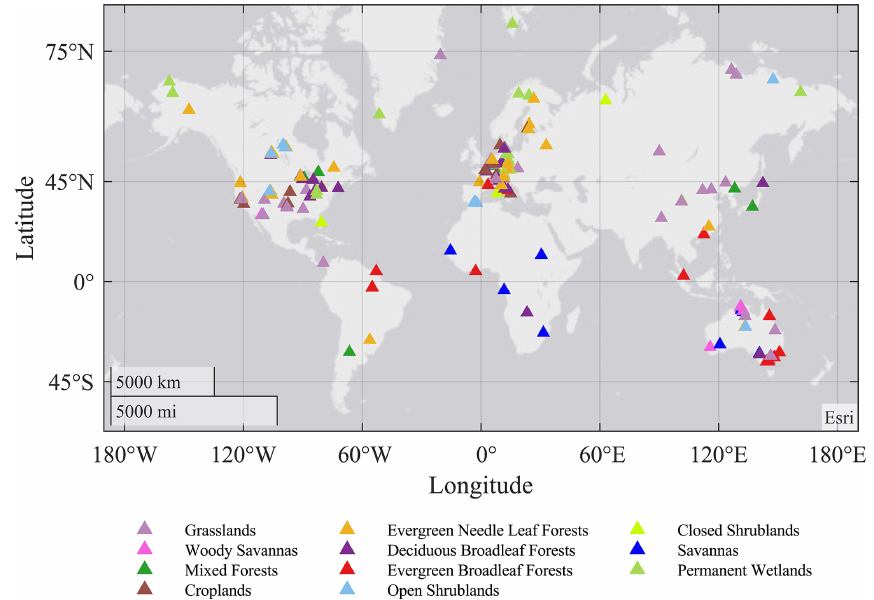
Figure 1. Global distribution of eddy covariance flux sites included in this study, color coded by their International Geosphere-Biosphere Programme (IGBP) biome